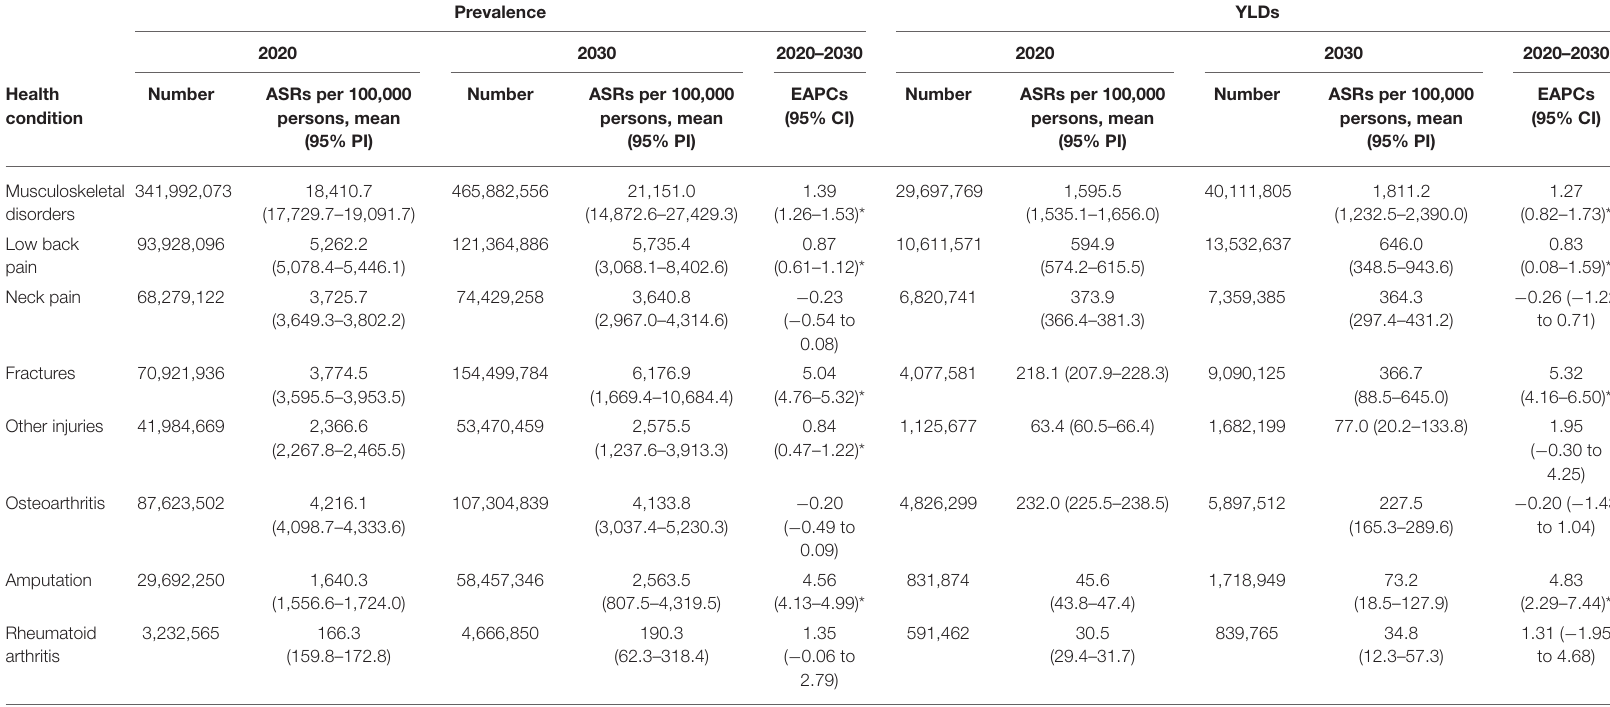
TABLE 2 | Musculoskeletal rehabilitation needs and trends in China from 2020 to